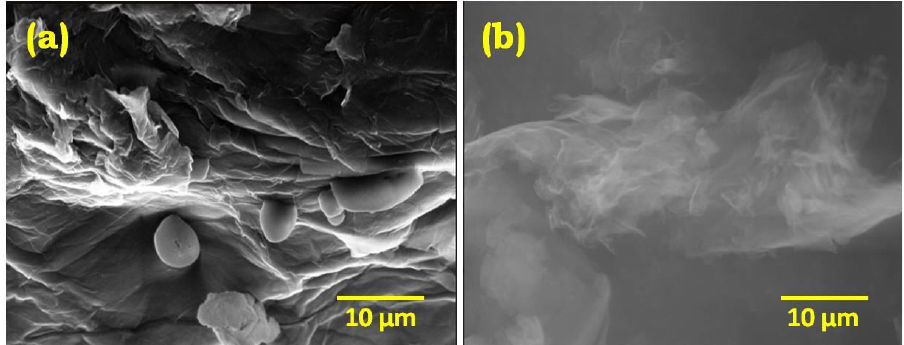
Figure 3. SEM images of ( a ) GO and ( b ) rGO. The contrast difference in the layered and thin transparent layer is observed for GO and rGO in the SEM micrograph, confirming the process of reduction of rGO from GO.